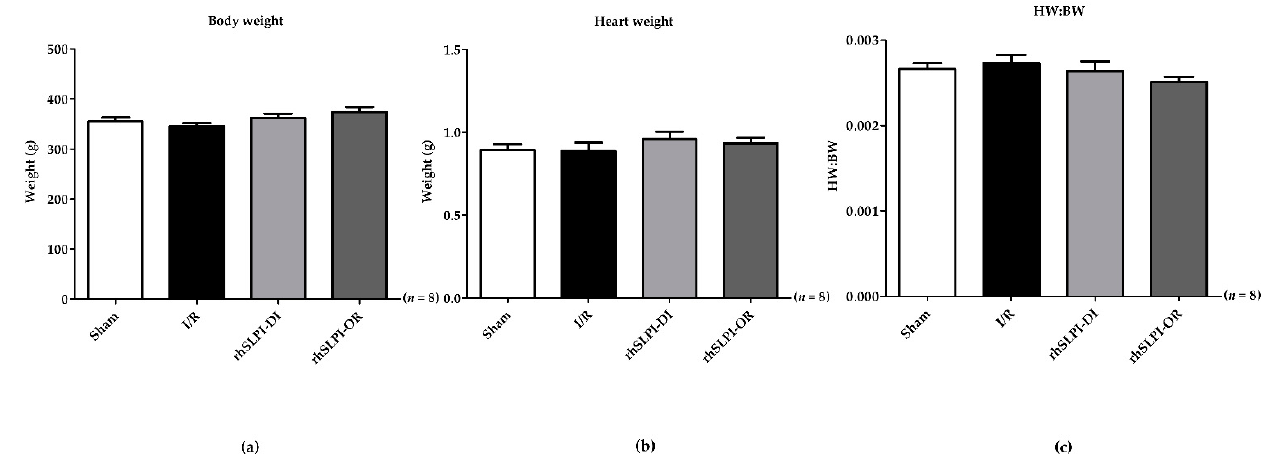
Figure 2. Determination of body weight of experimental animal before performing the surgical procedure of myocardial I/R injury ( a ), heart weight harvested at the end of the surgery ( b ) and heart weight to body weight ratio in rats of the study cohort ( c ). 3.2. Effect of Post-Ischemic rhSLPI Treatment on Infarct Size.